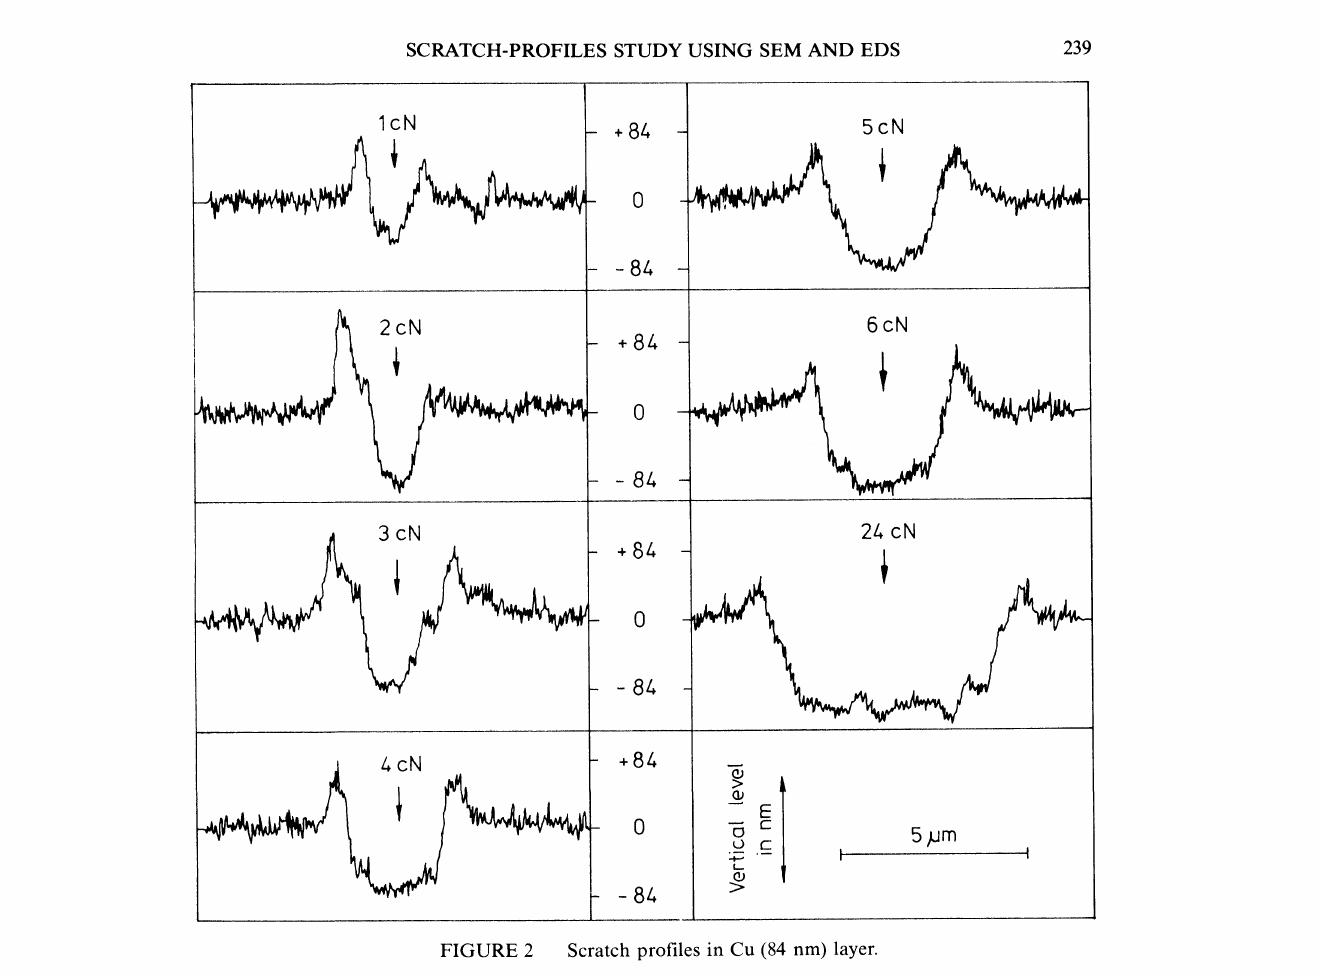
FIGURE 2 Scratch profiles in Cu (84 nm)